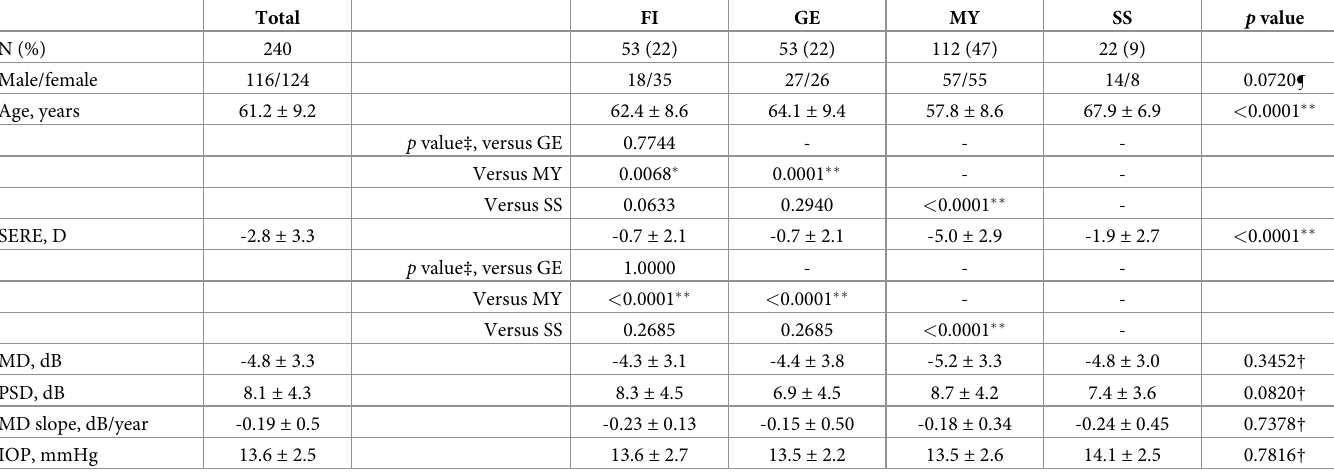
Table 1. Comparison of demographic subject data among different optic disc